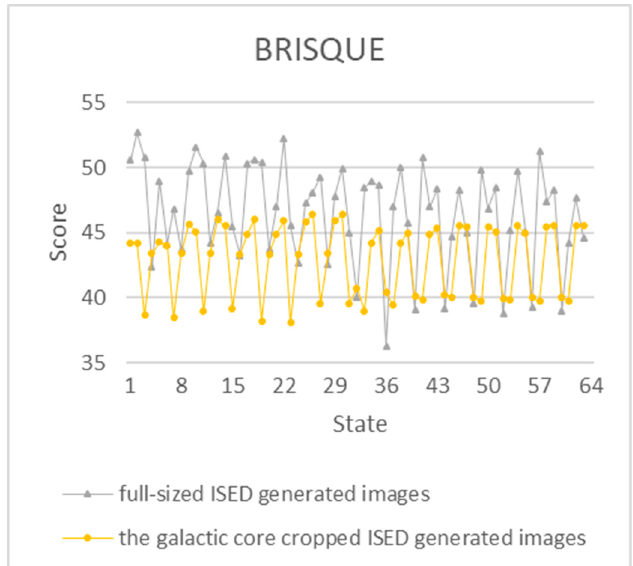
Figure 14. BRISQUE values of 63 ISED-generated images. The cropped images of M87 can be seen in Figure 9.